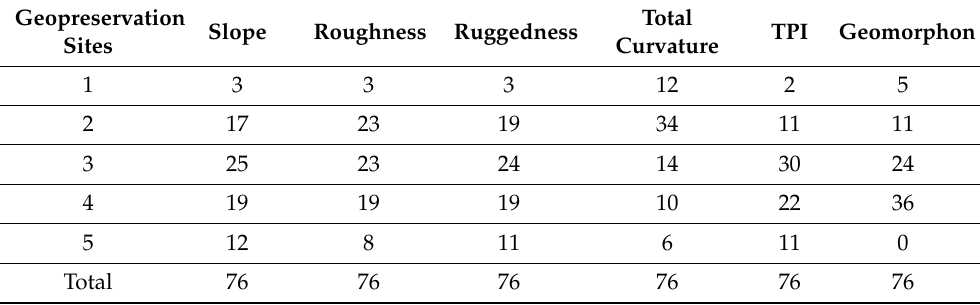
Table 6. Comparison of results of geodiversity assessment based on different geomorphological models evaluated with location from New Zealand Geopreservation